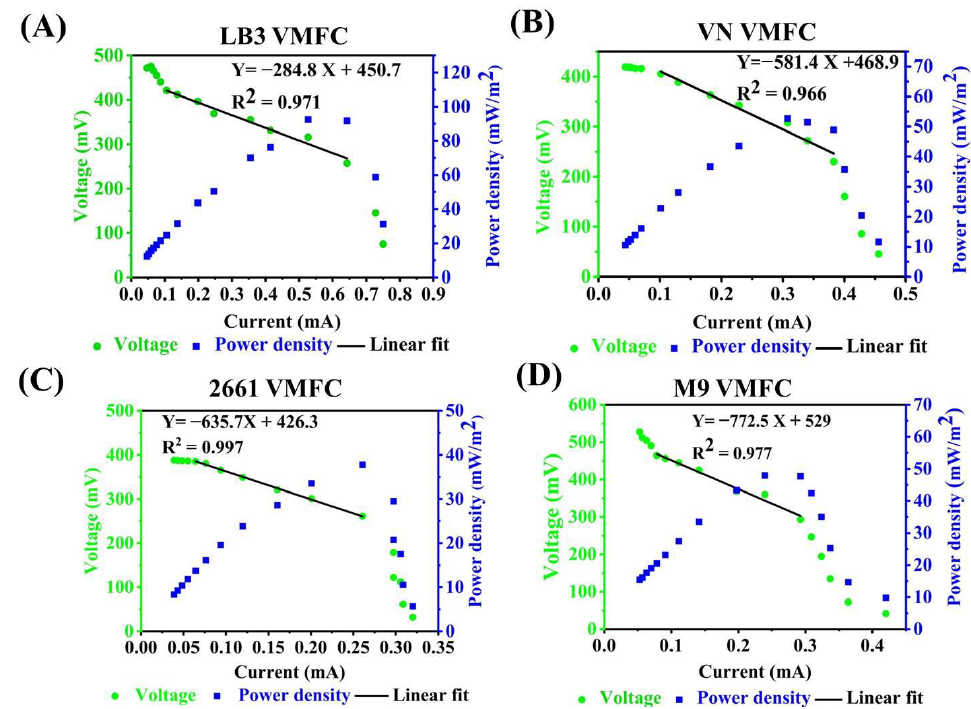
Figure 5. The performance evaluation of VMFCs with media switching. Polarization and power density curves obtained by varying the external resistance over a range of 100 to 9999 Ω from LB3 VMFC ( A ), VN VMFC ( B ), 2661 VMFC ( C ), and M9 VMFC ( D ).